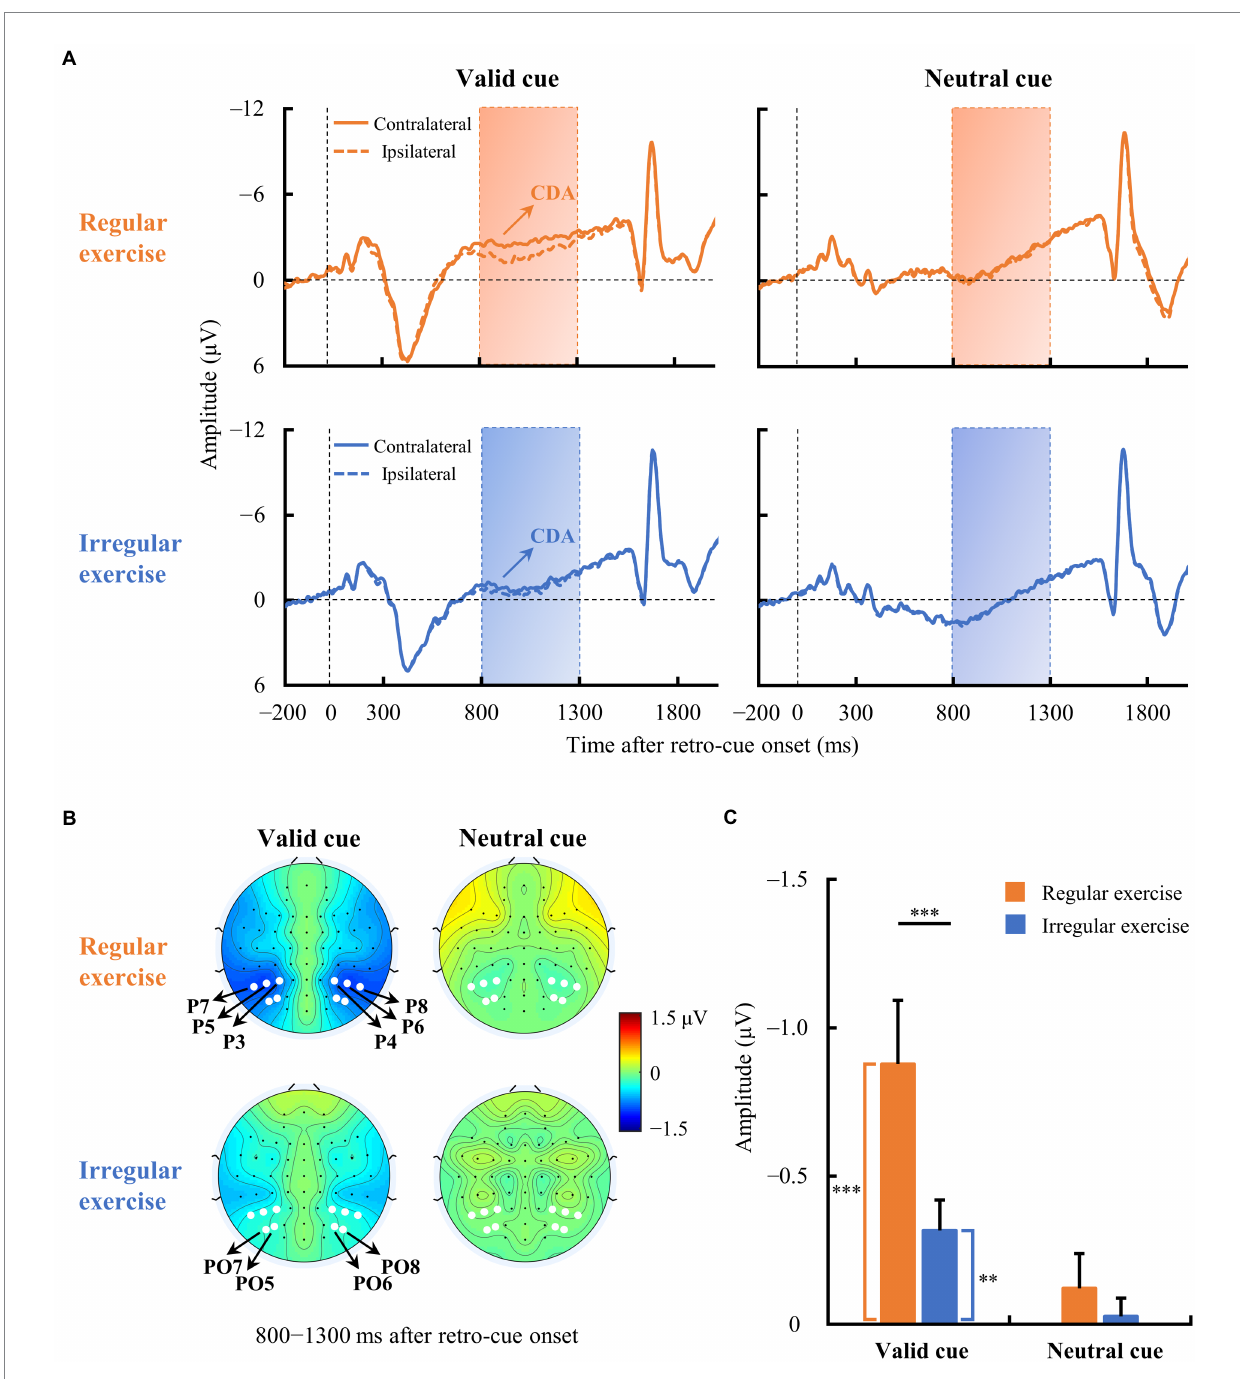
FIGURE 3 Event-related potential (ERP) waveforms averaged across contralateral and ipsilateral electrodes in the two exercise groups. (A) Averaged ERPs at contralateral and ipsilateral electrodes of the regular and irregular exercise groups in neutral and valid cue conditions. The horizontal dotted line indicates 0 μ V, and the vertical dotted line indicates the time of retro-cue onset. The rectangular area is the time window (800–1,300 ms) for CDA amplitude calculation. (B) Topographic maps of contralateral-minus-ipsilateral difference waves (800–1,300 ms after retro-cue onset) of regular and irregular exercise groups in neutral and valid cue conditions. The white dots are the electrodes (P3/4, P5/6, P7/8, PO5/6, and PO7/8) for ERP analysis. (C) Mean amplitudes of the difference waves between 800 and 1,300 ms after retro-cue onset of regular and irregular exercise groups in neutral and valid cue conditions. Error bars represent standard errors of the mean. ** p < 0.010, *** p <